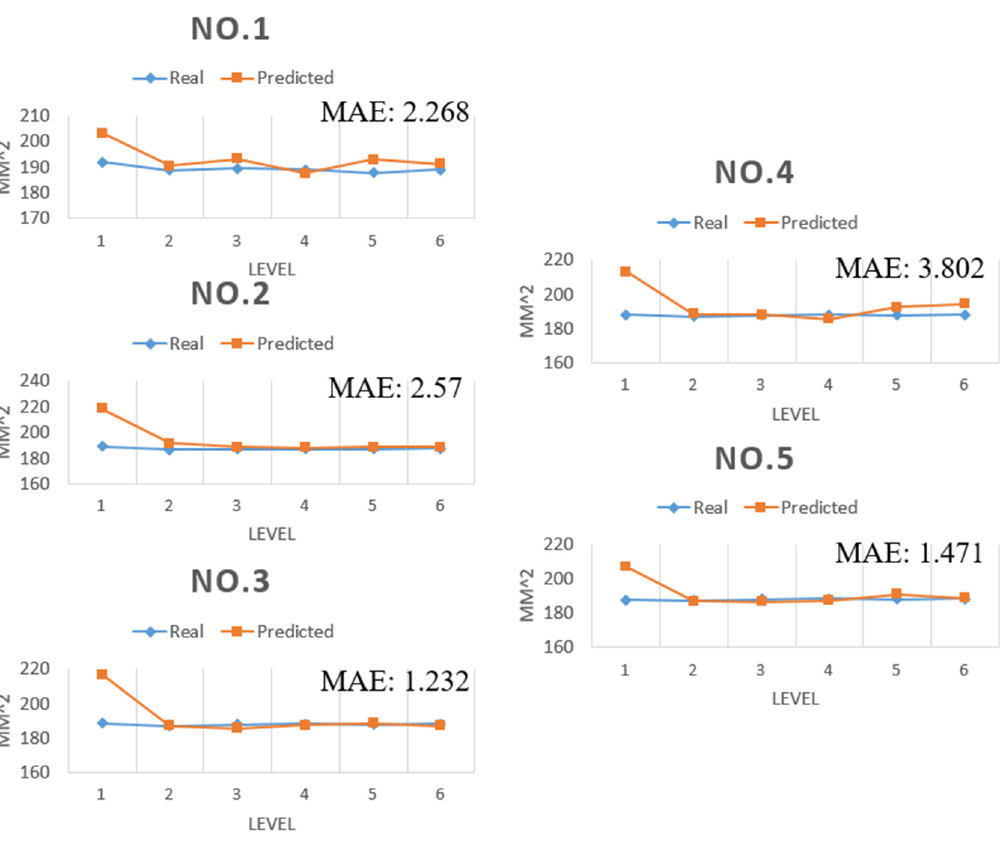
Figure 18. Model predictions compared with experimental results.